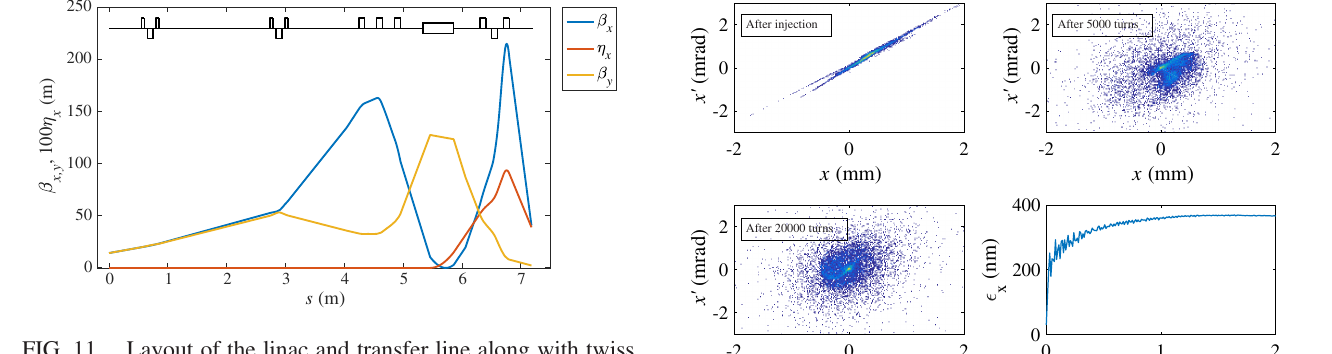
FIG. 11. Layout of the linac and transfer line along with twiss functions and dispersion function. The start of the beamline corresponds to the exit of the accelerating tube.